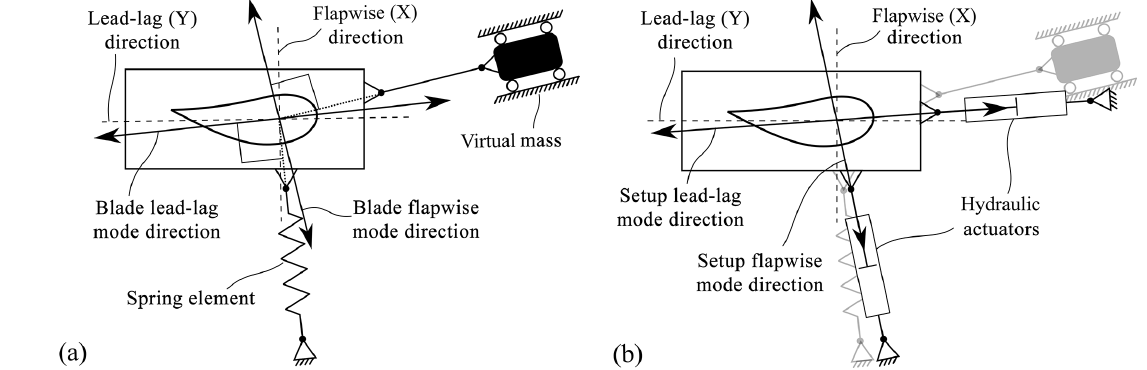
Figure 2. Angle for application of load elements: (a) passive elements according to blade mode shape and (b) actuators according to setup mode shape.